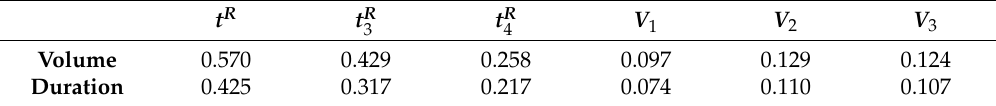
Table 2. Homogeneity test of the Pannonian Basin for flood volumes and